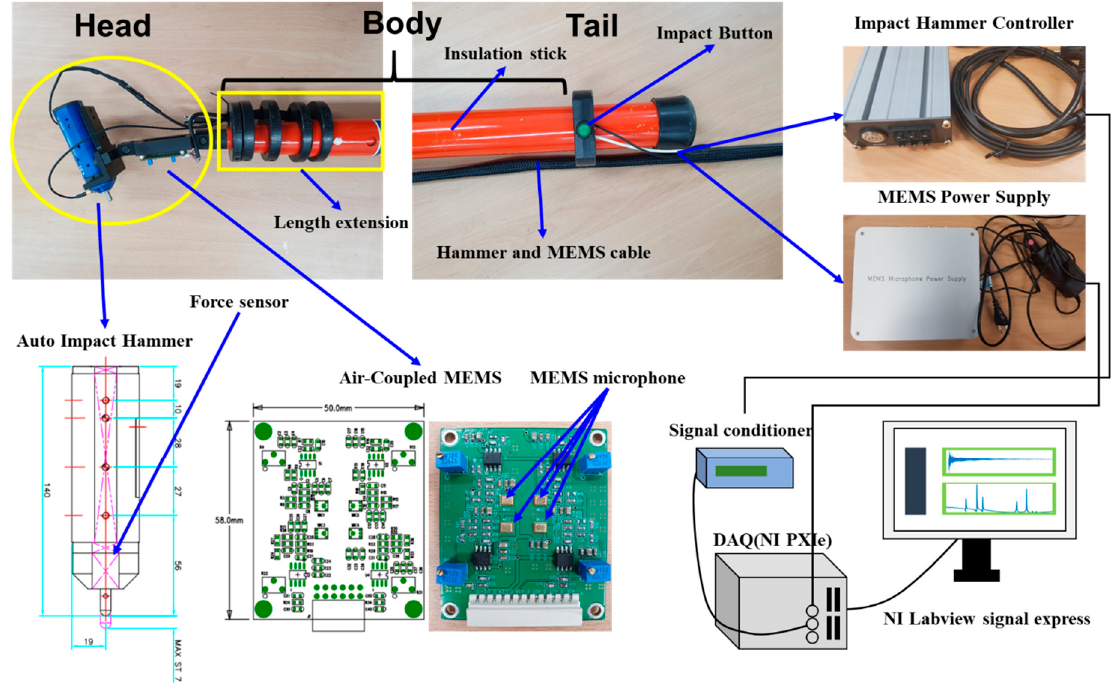
Figure 2. Developed equipment and experimental setup.